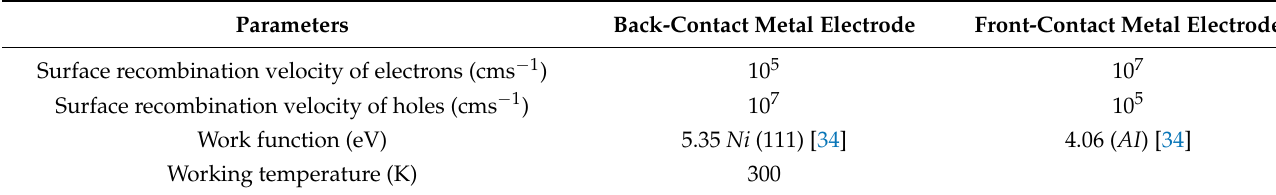
Table 3. Input parameters used for front and back contacts in the simulation.